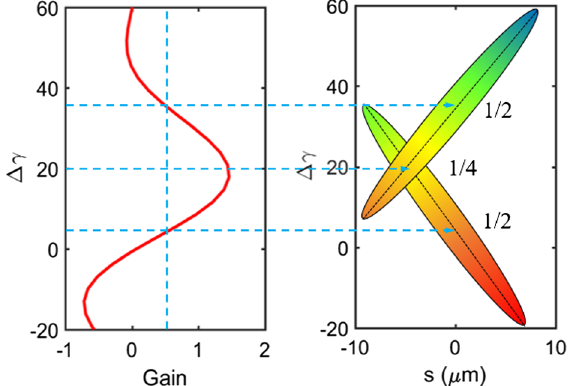
FIG. 4. The schematic of 3 kA peak current XFELO single pass gain (red solid line) and optimized chirped-beam. Assuming that 50% gain is necessary, and the 1 = 4 bunch tail point corresponds to the maximum single pass gain, while the central point relates to 50% single pass gain. Thus only bunch tail gets enough gain to compensate the round trip net loss, while bunch head does not lase significantly inside the XFELO.